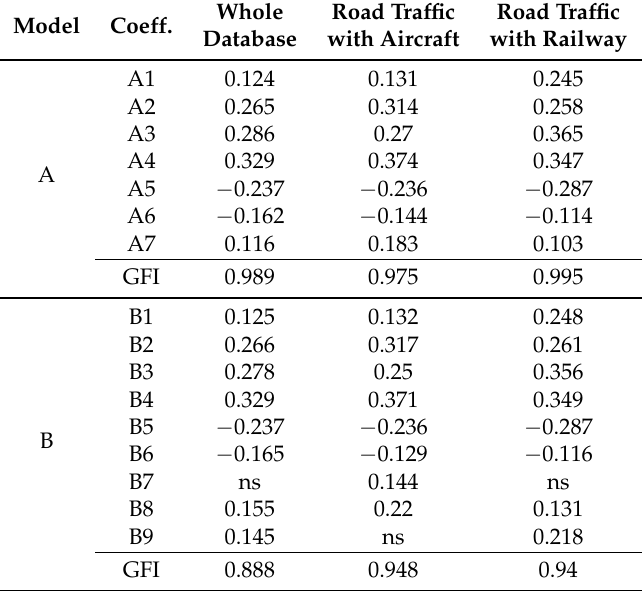
Table 3. Standardized coefficients used in models of the partial annoyance due to road traffic noise. Models are based on different samples of the French in situ survey database. ns: non-significant.